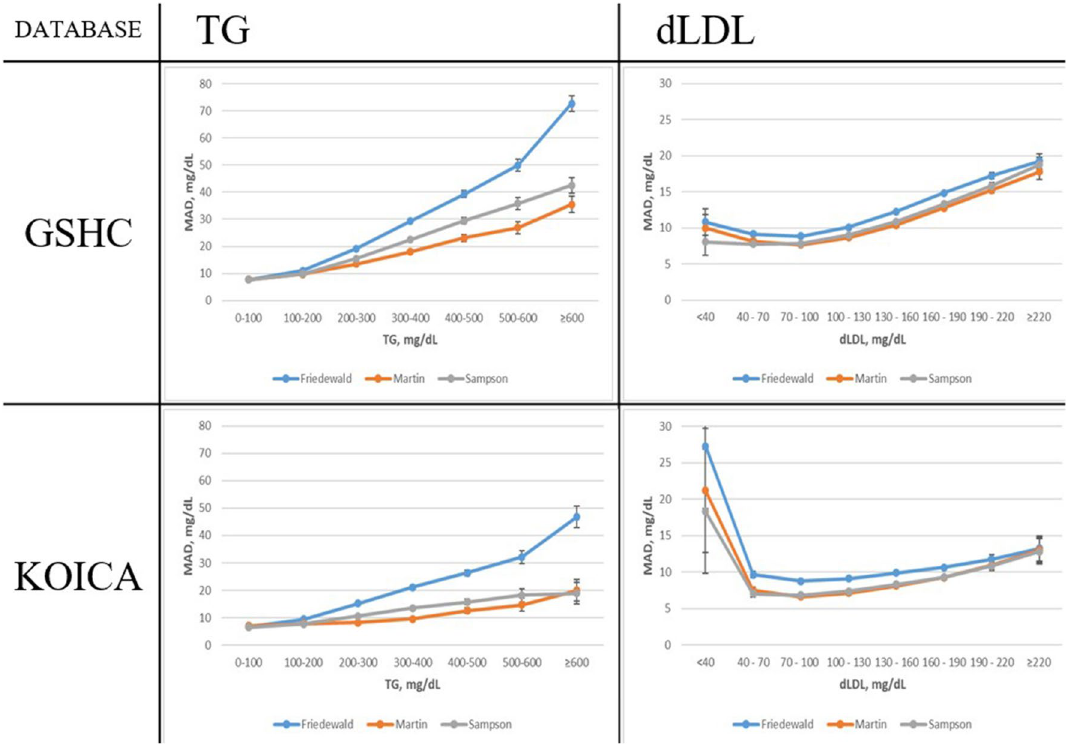
Figure 4. Comparison of the mean absolute difference scores between direct LDL-C and different estimated LDL-C values for various TG and LDL-C levels. TG triglyceride; LDL-C low-density lipoprotein cholesterol; GSHC Gangnam Severance Hospital Check-up; KOICA Korea Initiatives on Coronary Artery